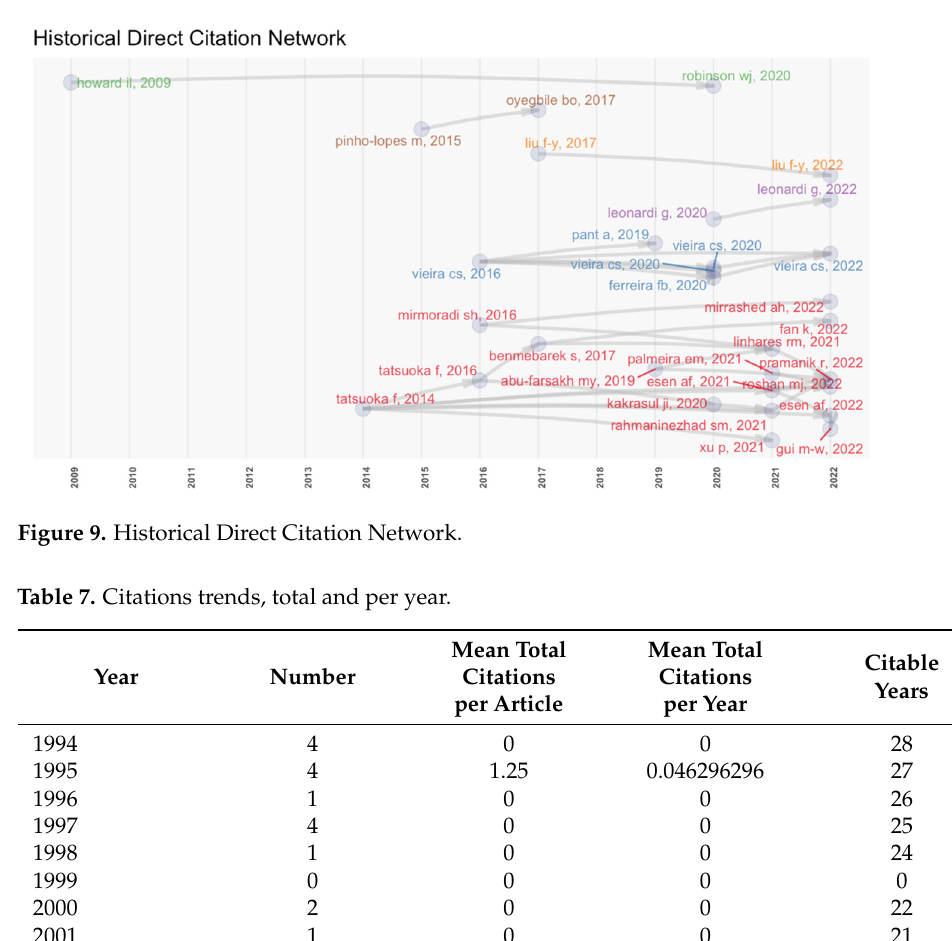
Figure 8. Scientific production overtime.